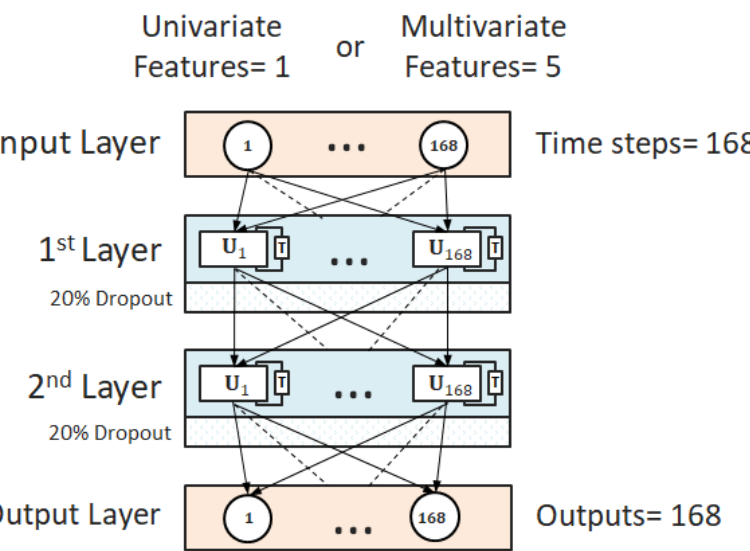
Figure 3. The proposed deep LSTM network with 2 LSTM layers with dropout layers. For clarity, the temporal recurrent structure is not